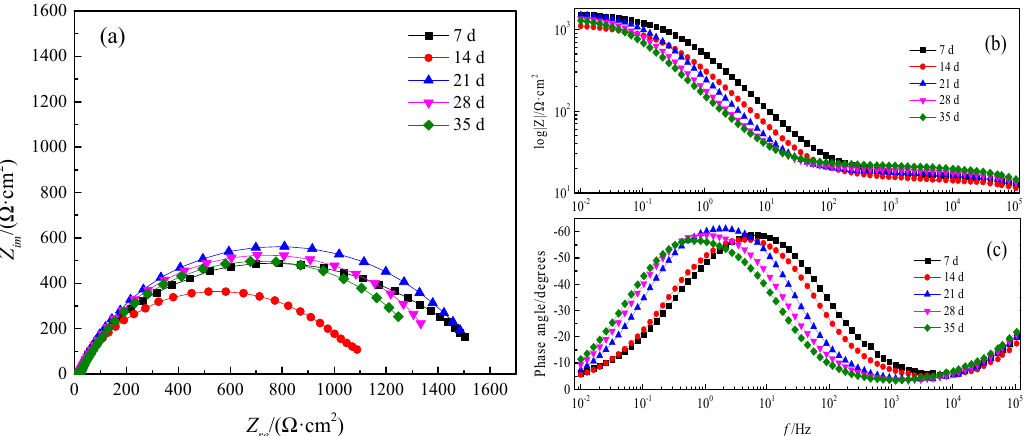
Figure 5. Electrochemical impedance spectra (EIS)of Q235B steel in desulfurization solution with 7 days, 14 days, 21 days, 28 days and 35 days, respectively; ( a ): Nyquist plot, ( b ): Bode magnitude, ( c ): Phase angle plot.